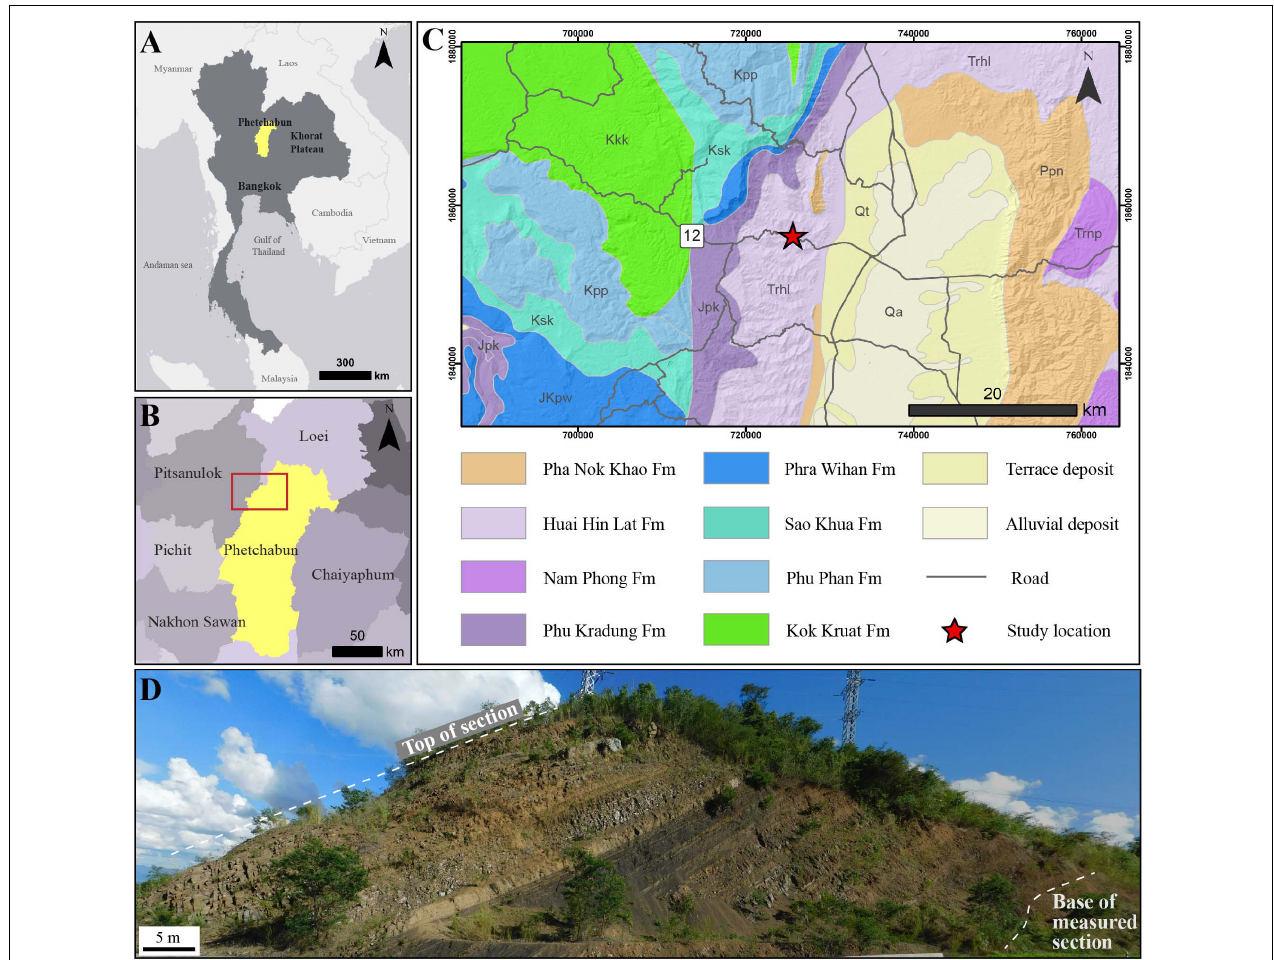
FIGURE 2 | Maps show the study location (A) Location of Phetchabun province, central Thailand, (B) close up of the study area in northwestern part of Phetchabun province, (C) the geological map of the study area which the study location situated in the Huai Hin Lat Formation, and (D) the studied outcrop provides continuous parallel beds of siliciclastic sedimentary